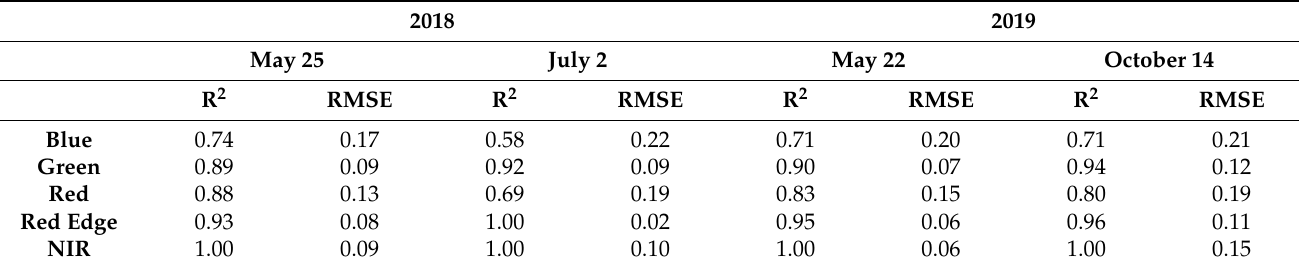
Table 7. Coefficient of determination R 2 and RMSE (% reflectance) of the MS RedEdge-M camera and ASD Fieldspec 3 measurements of reference panels for four sampling dates.